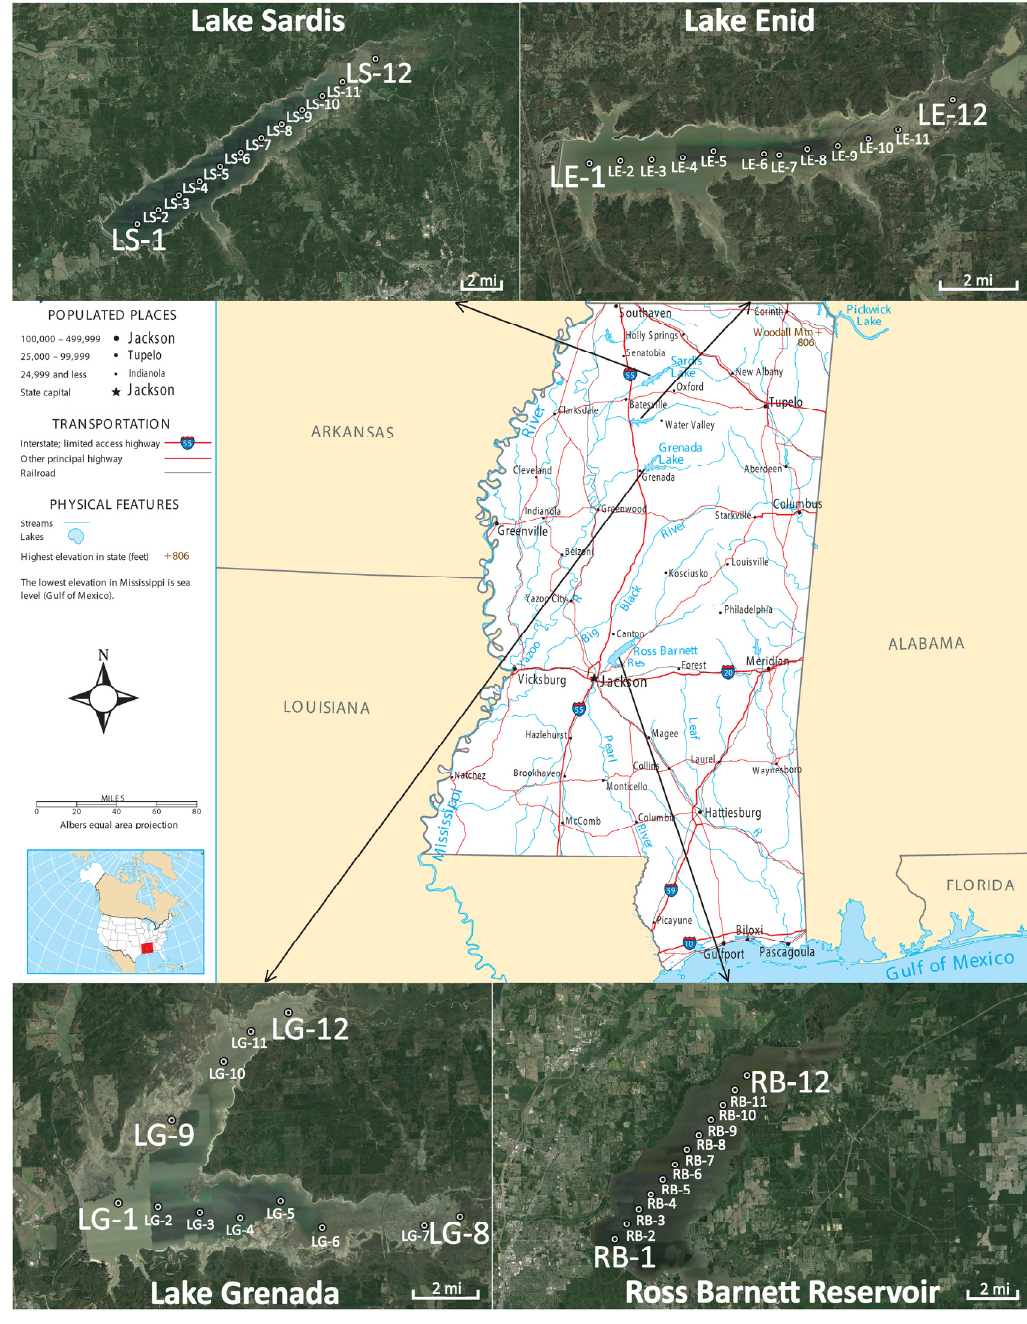
Figure 1. Location map of Lakes Sardis, Enid, Grenada, and Ross Barnett Reservoir in Mississippi, USA with twelve sampling sites in each of the water bodies